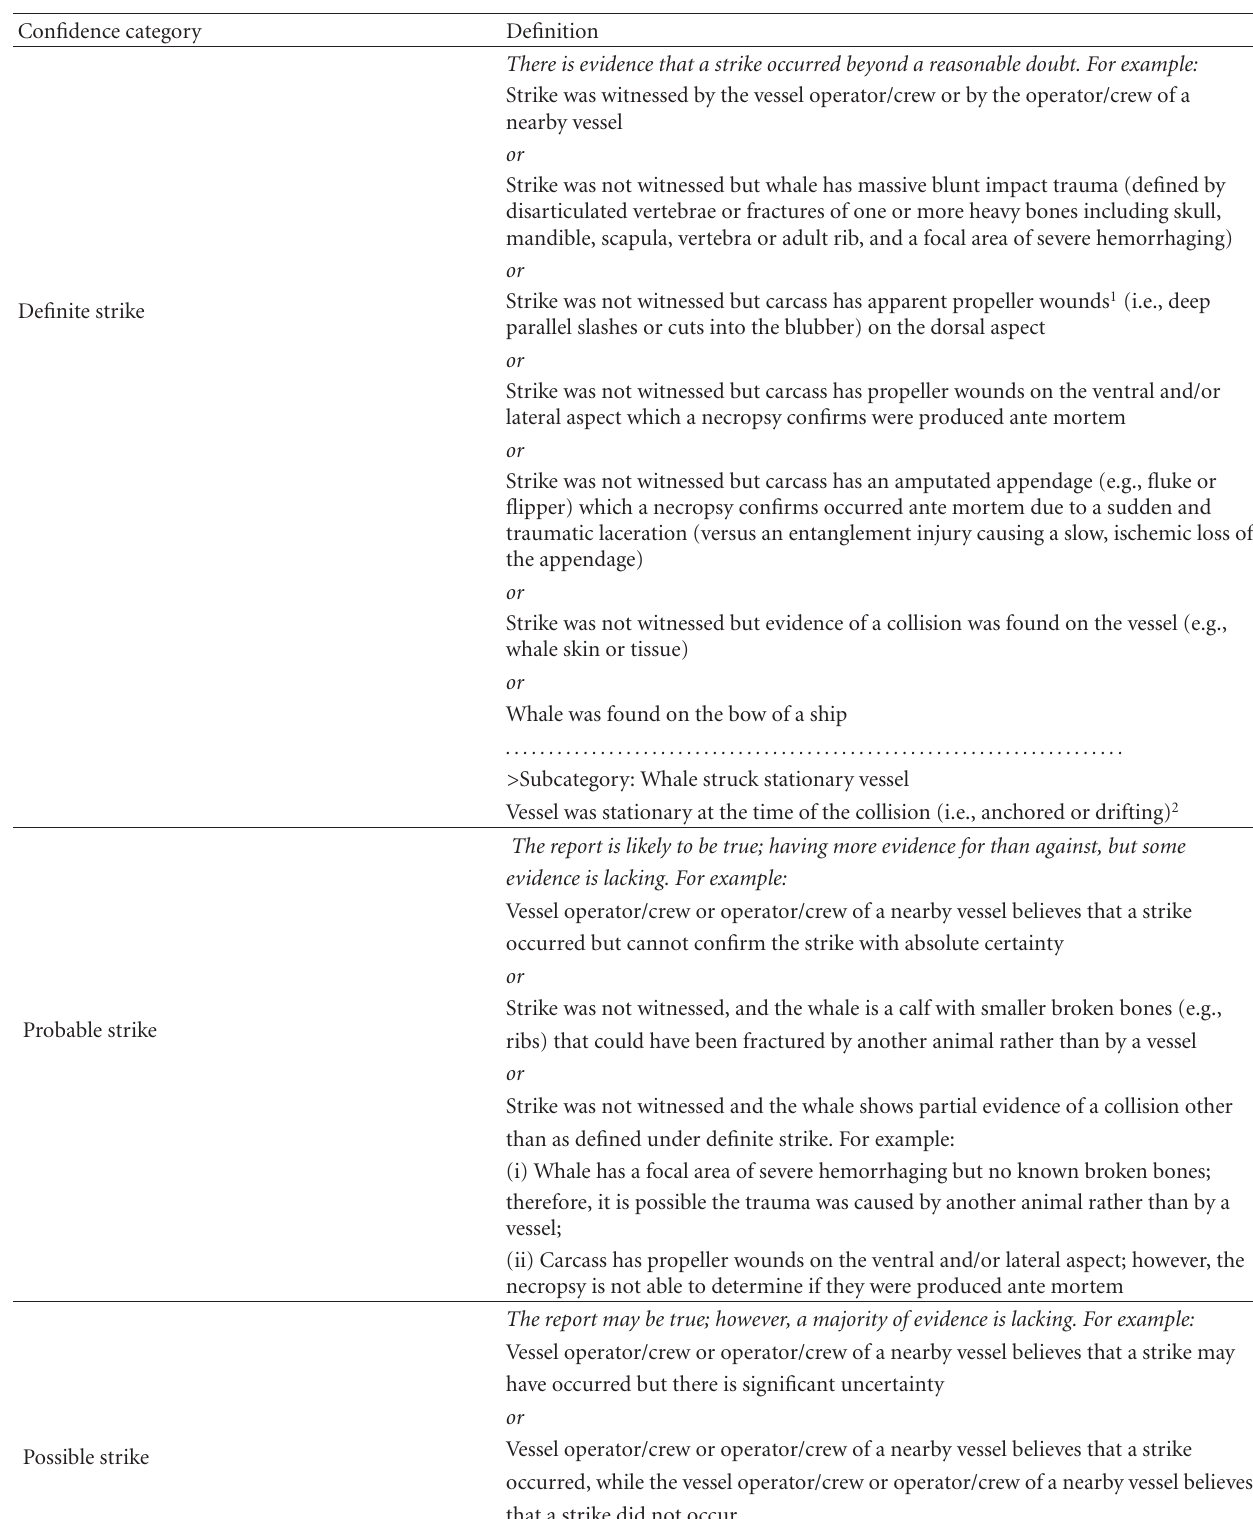
Table 1: Ship strike confidence